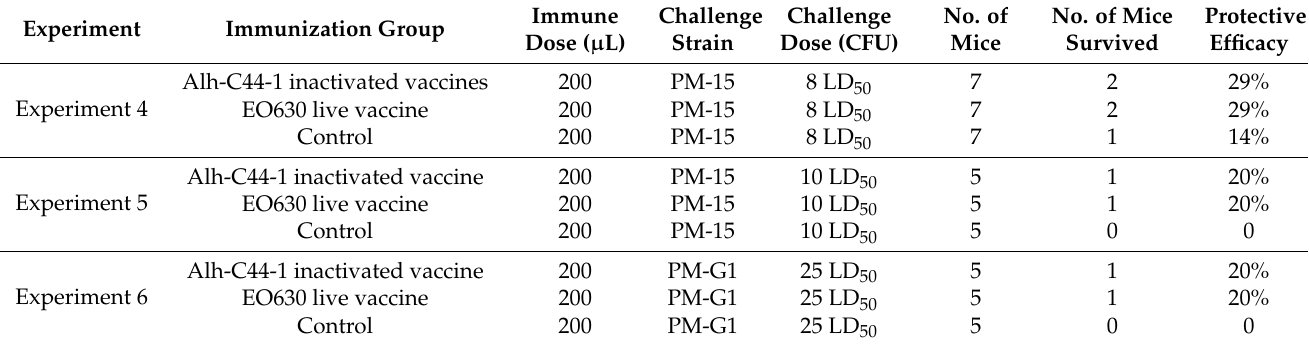
Figure 3. Survival rates of a mouse model immunized with traditional vaccines, after challenge with serogroup A strains. All mice were intraperitoneally challenged with ( a ) 18 LD 50 of strain PM-5, ( b ) 29 LD 50 of strain PM-5, or ( c ) 10 LD 50 of strain PM-10. The mice were observed for 14 days after the challenge. Table 3. Immune protection afforded by traditional vaccines against P. multocida serogroup D